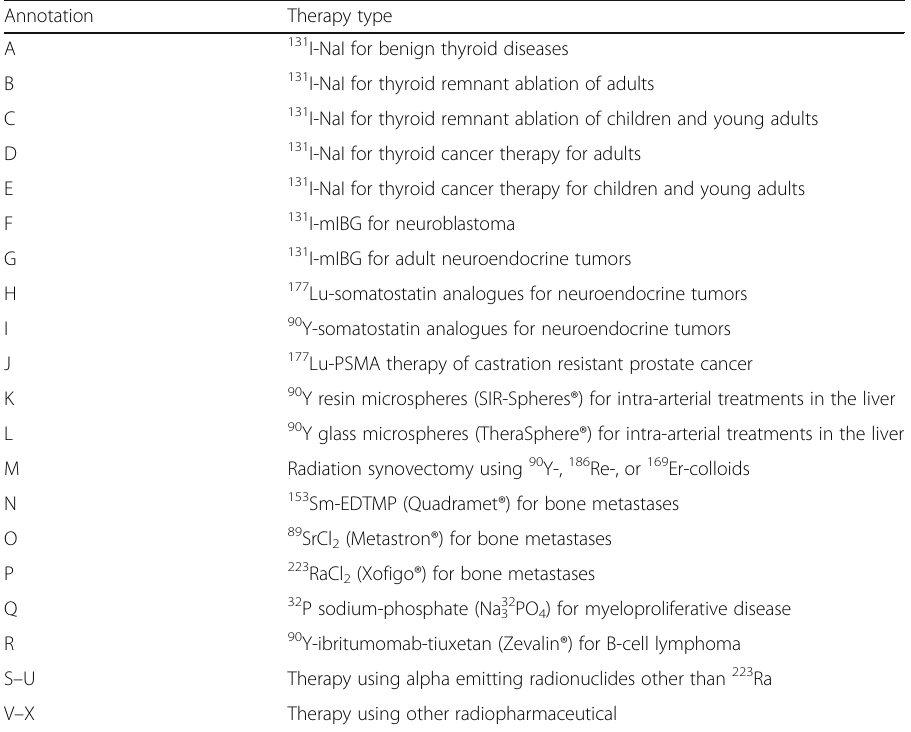
Table 1 Therapy types included in the survey, each on a separate page. Therapies A – R were explicitly asked for, while S – U and V – X were included as